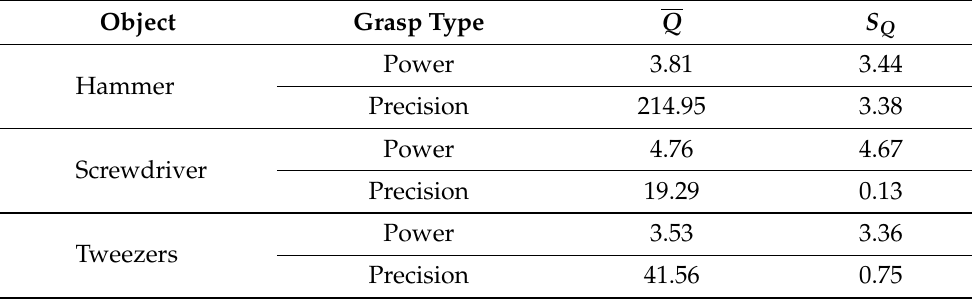
Table 5. Test subjects performance, assisted